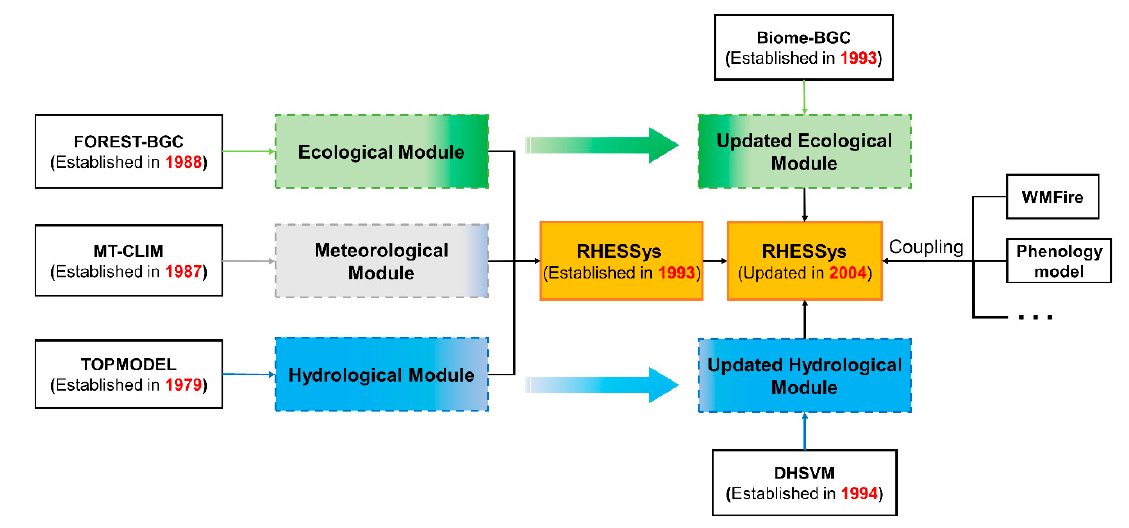
Figure 1. The development history of RHESSys.